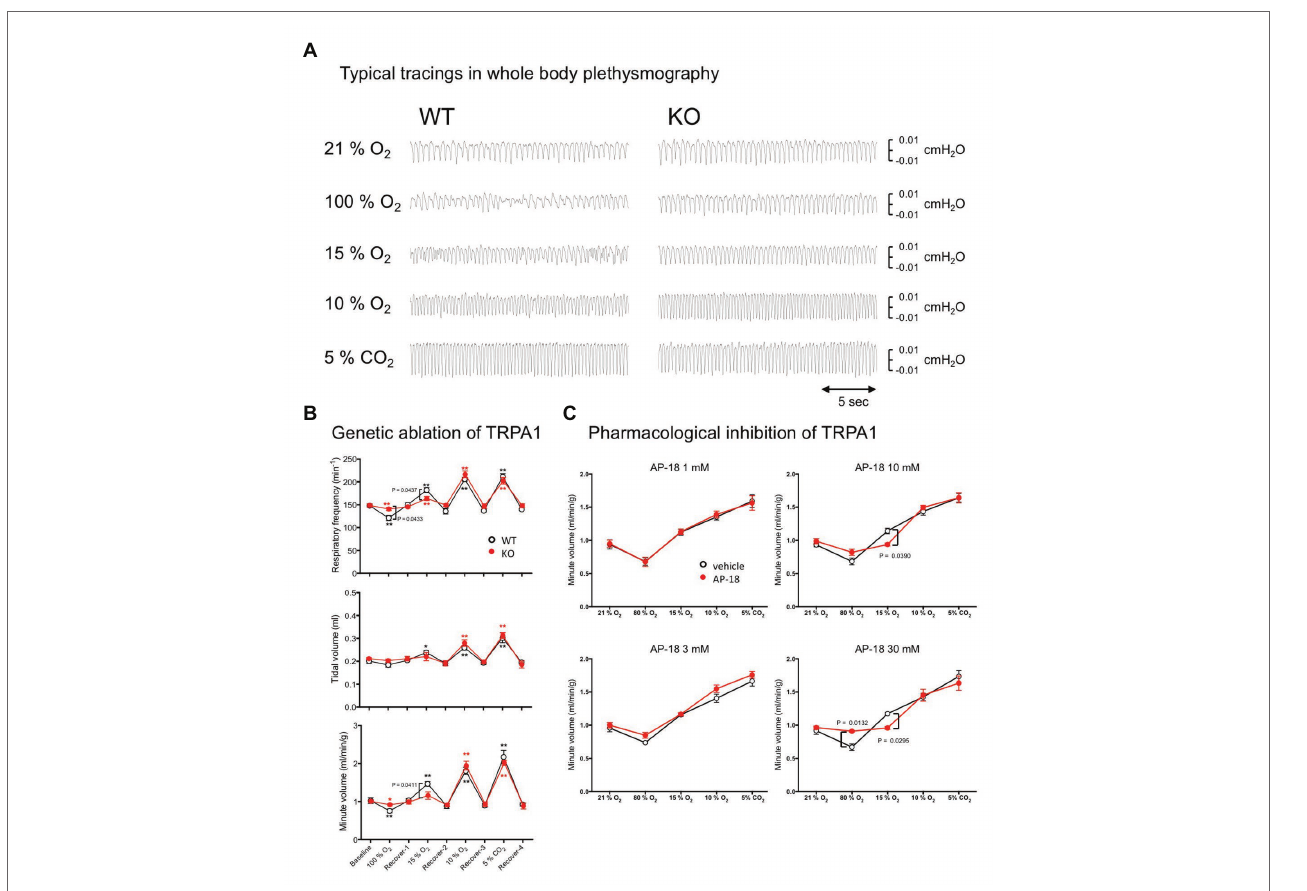
FIGURE 5 | Effect of genetic and pharmacological inhibition of TRPA1 on respiratory chemoreflex. (A) Representative tracing of pressure signals in whole body plethysmography. Respiration of WT and KO mice was measured using flow-through type whole body plethysmography. Every gas condition was maintained for 3 min, and the data were collected during the last 20-s period. Each stimulus was separated by intervals of 20 min or more of normal room air. Plethysmographic signal that is a pressure difference between the measuring chamber and the reference chamber, and O 2 concentration in the measuring chamber were continuously monitored. Data for baseline and recovery periods were obtained during the last 3 min before the next stimulation. (B) Group data obtained in whole body plethysmography. Data are shown as mean ± SEM. n = 8 for WT and n = 8 for KO mice. Two-way ANOVA revealed that there was a significant difference among gas conditions ( F 8, 112 = 101.7, p < 0.0001) and interaction between gas condition and genotype ( F 8, 112 = 2.415, p = 0.0191). * p < 0.05, ** p < 0.01 as compared to preceding control values (one-way ANOVA followed by Sidak’s multiple comparisons test). Values of p in the figure were calculated by Sidak’s multiple comparison test to compare between WT and KO mice. (C) Using four sets of WT animals ( n = 5/group), the possible effect of the TRPA1-blocker, AP-18, on respiratory chemoreflex was examined. Every animal was exposed to an aerosol made from vehicle (20% ethanol in saline) and an assigned concentration of AP-18 solution. Data are shown as mean ± SEM. Two-way ANOVA revealed that there was a significant interaction among drugs × gas conditions for 10 mM ( F 4, 16 = 3.668, p = 0.0265) and 30 mM ( F 4, 16 = 6.386, p = 0.0029) but not for 1 mM ( F 4, 16 = 0.1507, p = 0.9600) and 3 mM ( F 4, 16 = 0.7821, p = 0.5532). Values of p in the figure were calculated by Sidak’s multiple comparison